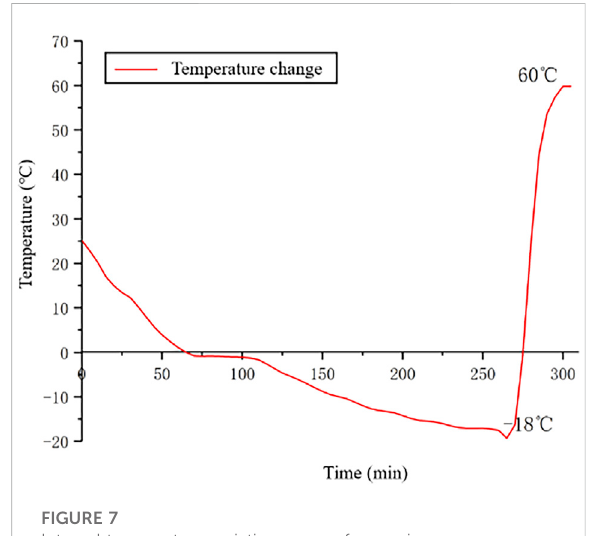
FIGURE 7 Internal temperature variation curve of a